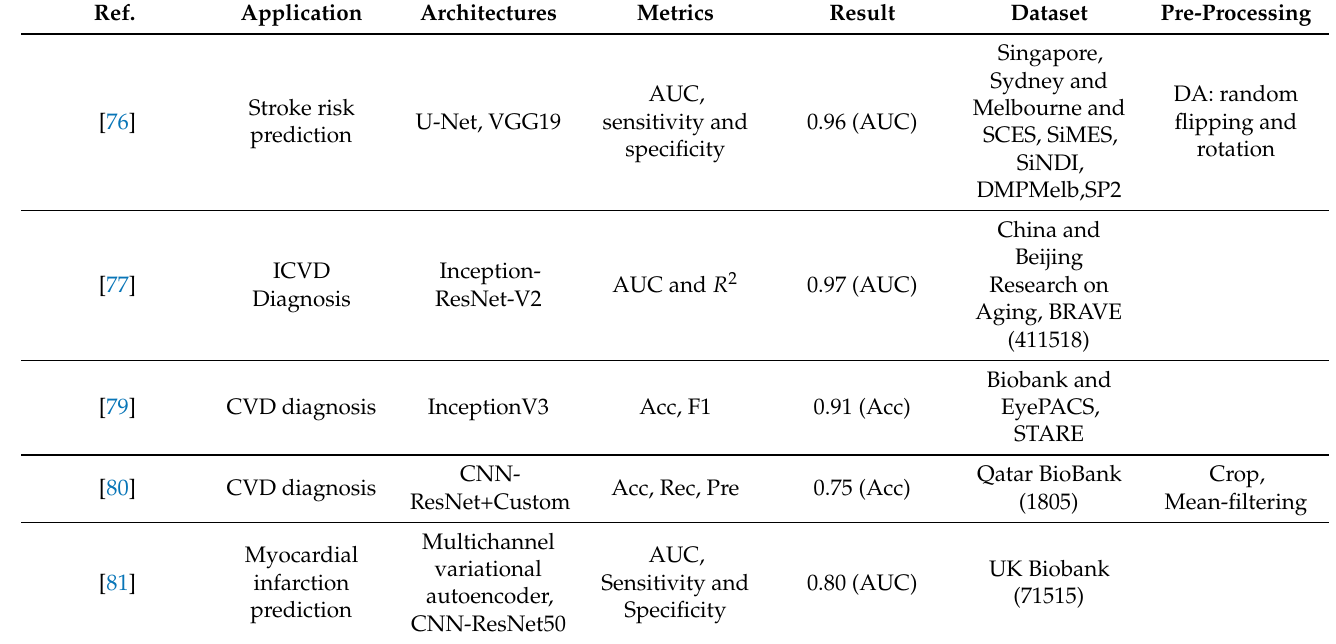
Table 6. Automated prediction of cardiovascular events